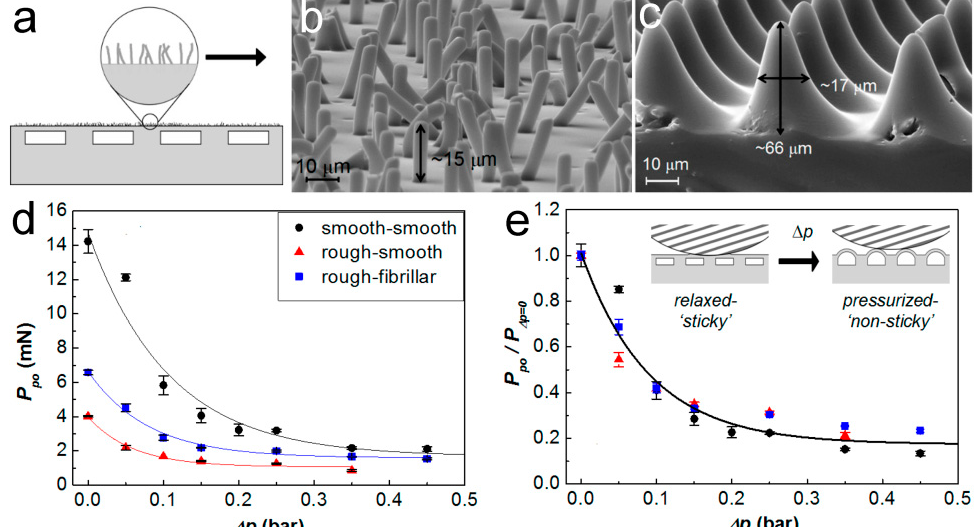
Figure 9. Polydimethylsiloxane (PDMS) film embedded with microchannels for adhesion. ( a ) Schematic of the channel structure with textured outer surfaces and scanning electron microscopy (SEM) images of ( b ) fibrillar and ( c ) conical pillars. ( d ) Dependence of the pull-off force ( P po ) and ( e ) the P po normalized to the preload ( P Δ po=0 ) on the increase of differential pressure in the microchannels ( Δ p ). Reproduced with permission from [129].